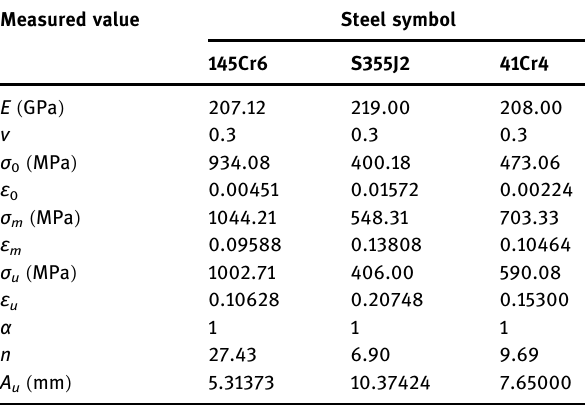
Table 2: The quantities necessary to determine selected material constants measured during experimental tests [ 9 – 12 ] (